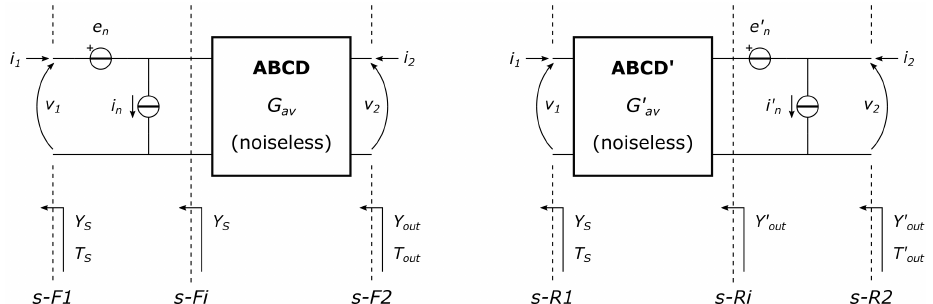
Figure 1. Model of a generic linear noisy 2-port network. ( Left ): forward case. ( Right ): reverse case. The reverse case can be viewed as reversing the noisy thru and the noiseless 2-ports individ- ually and then swapping them. It can be observed that: Y S , NT = Y S , T eq , NT = T eq ; Y (cid:48) (cid:48) = T (cid:48) − T T (cid:48) S G av out eq , NT